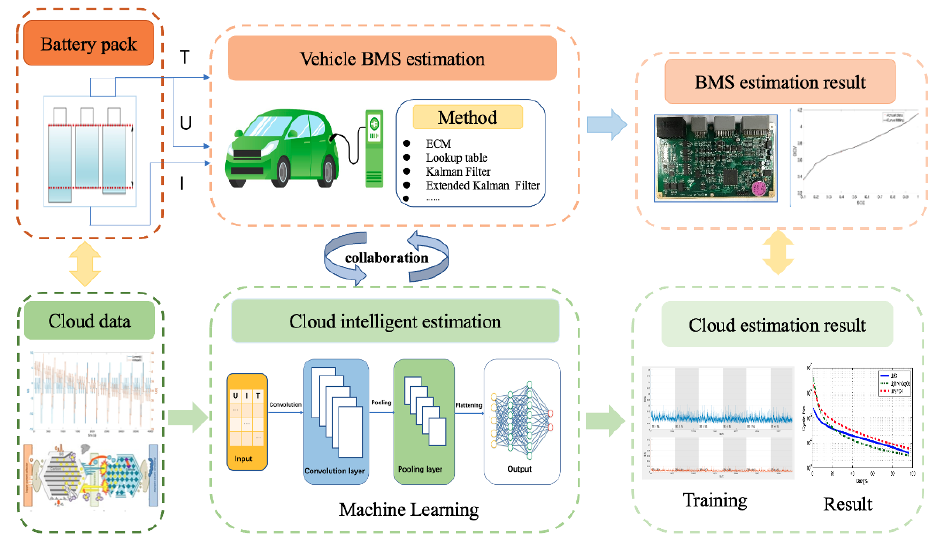
Figure 1. The schematic of vehicle-cloud